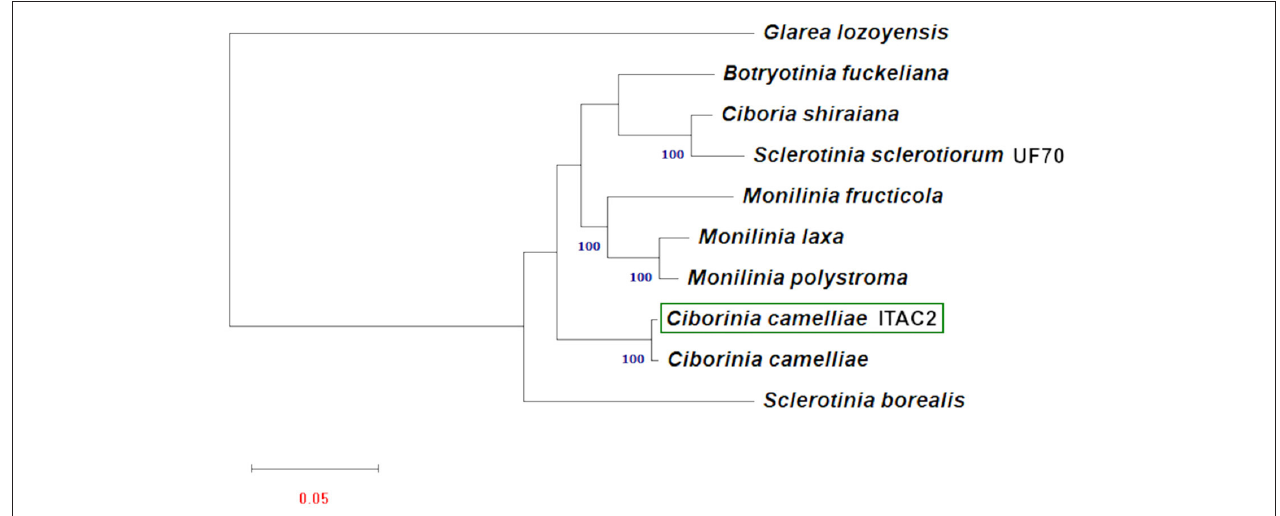
FIGURE 4 | Maximum Likelihood phylogenetic tree based on 14 encoded mitochondrial genome. Blue numbers are bootstrap support values ( > 90). Red number denotes branch length. The GeneBank accession numbers are listed as follow: Botryotinia fuckeliana (KC 832409), Ciboria shiraiana (CM 017871.1), Ciborinia camelliae (GCA_001247705.1), Ciborinia camelliae strain ITAC2 (OK326902) Glarea lozoyensis (NC_031375.1), Monilinia fructicola (NC_056195.1), Monilinia laxa (NC_051483.1), Monilinia polystroma (GCA_002909645.1), Sclerotinia borealis (KJ434027) and Sclerotinia sclerotiorum